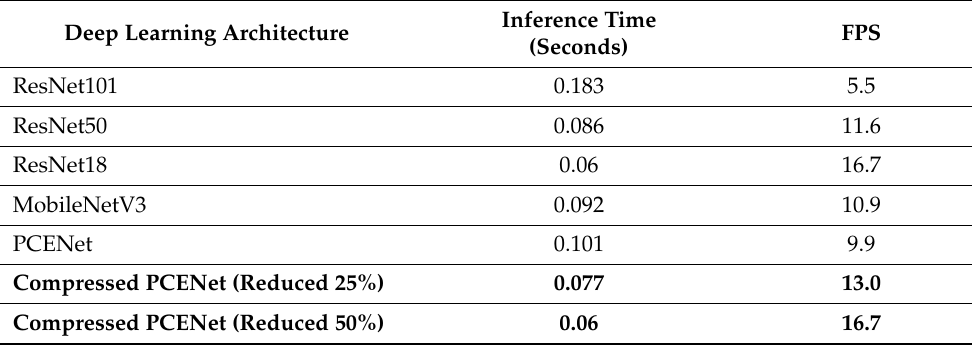
Figure 7. Deployment scheme from server to the edge platform. Table 5. Inference time assessment on the edge platform. Table 5. Inference time assessment on the edge